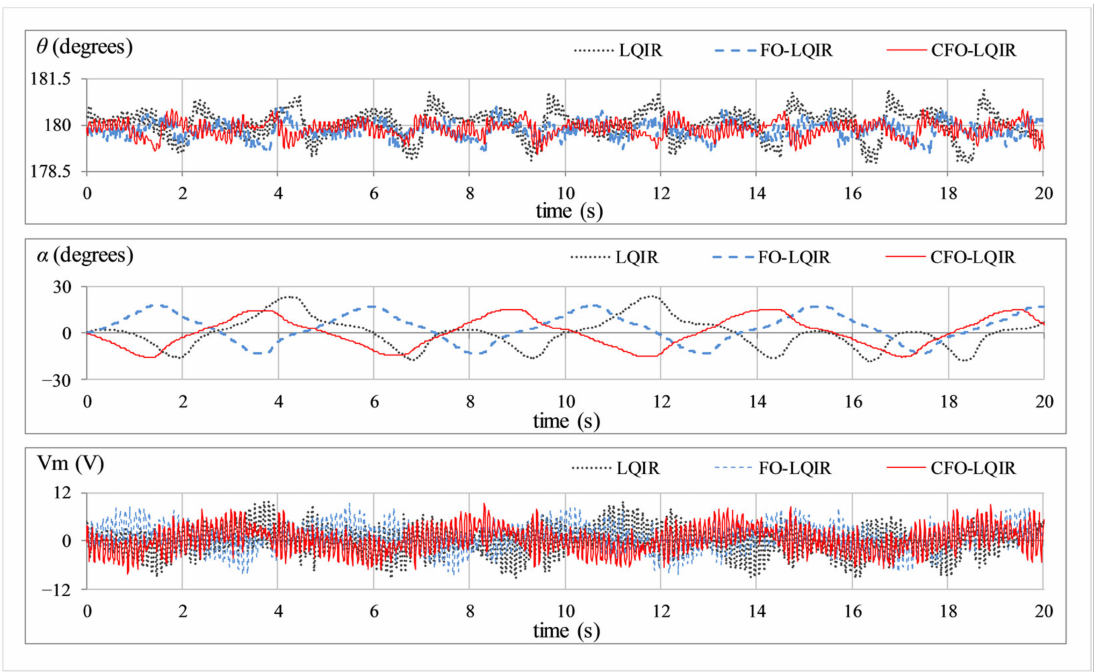
Figure 7. SRIP’s response under sinusoidal